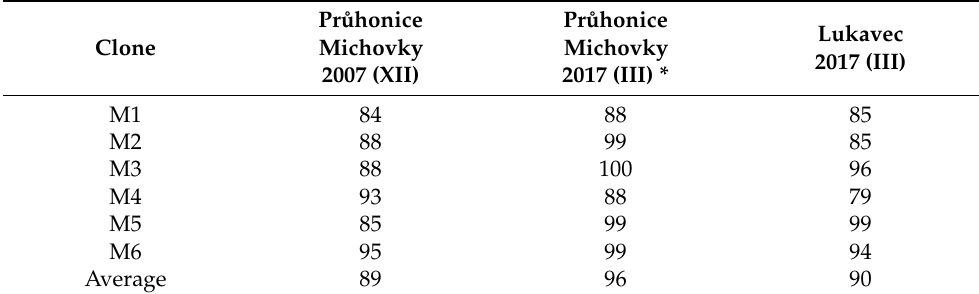
M6 95 99 94 Average 89 96